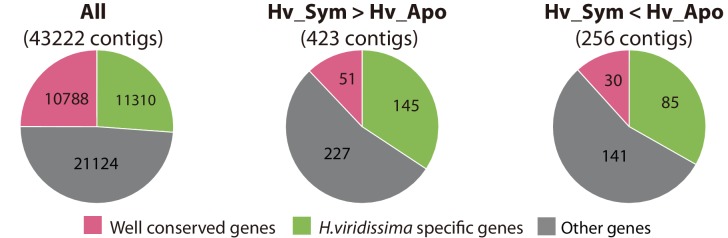
Conserved genes and species-specific genes differentially expressed in symbiotic Hydra.Distribution of well-conserved Hydra viridissma genes (pink), Hydra viridissima-specific genes (green) and other genes (shared by some but not all metazoans, gray) among eight metazoans: Hydra magnipapillata, Acropora digitifera, Nematostella vectensis, Strongylocentrotus pupuratus, Branchiostoma floridae, Homo sapiens and Drosophila melanogaster and Hydra viridissima A99. Pie charts are shown for all contigs (All), up-regulated contigs (Hv_Sym > Hv_Apo) and down-regulated contigs (Hv_Sym < Hv_Apo).